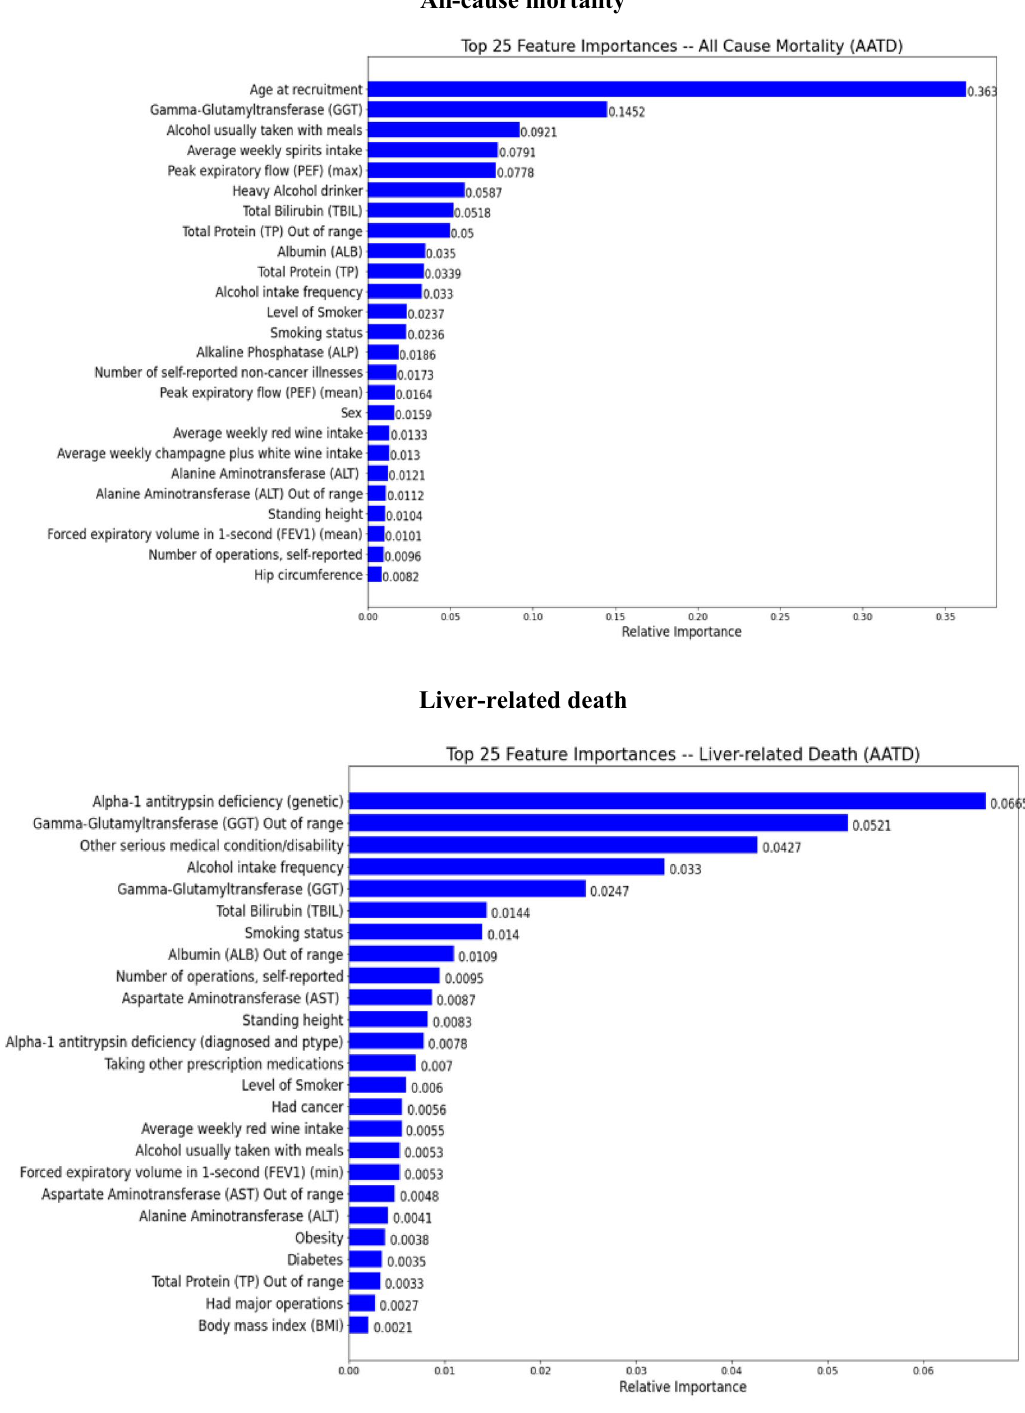
Figure 6. Feature importance in the final stacking ensemble learning model for patients AATD-LD (N =